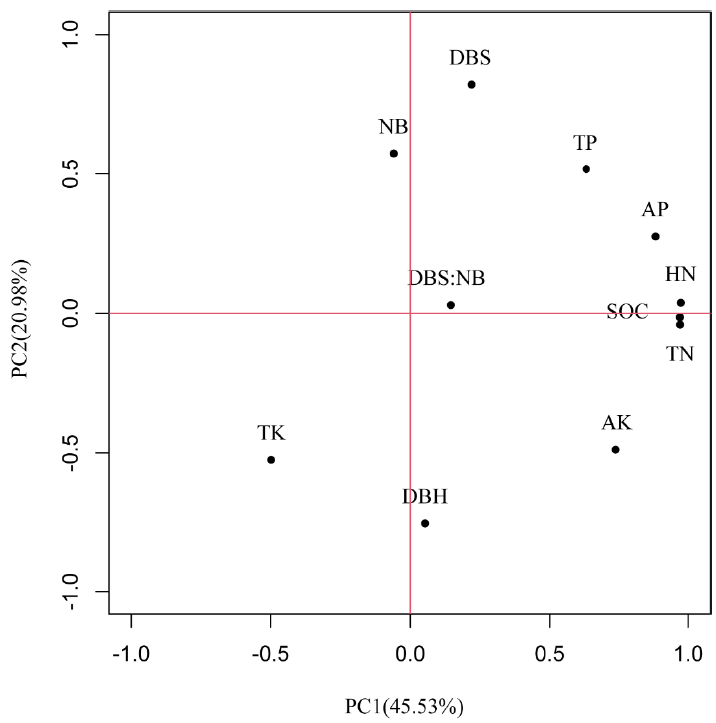
Figure 3. Principal component analysis (PCA) of soil nutrient content and stand characteristics.